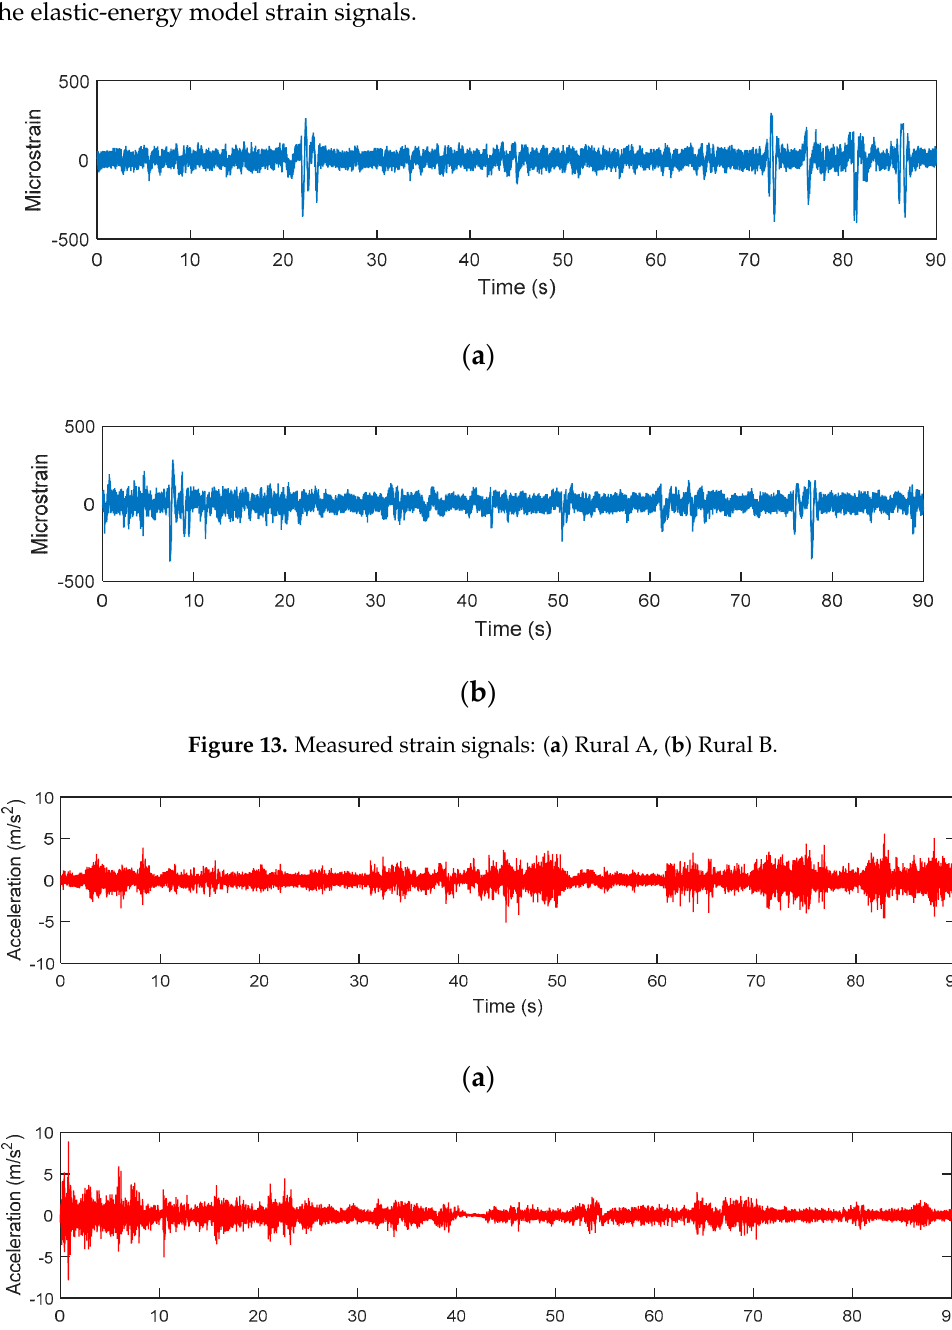
Figure 12. Elastic-energy strain signals: ( a ) Rural A, ( b ) Rural B.